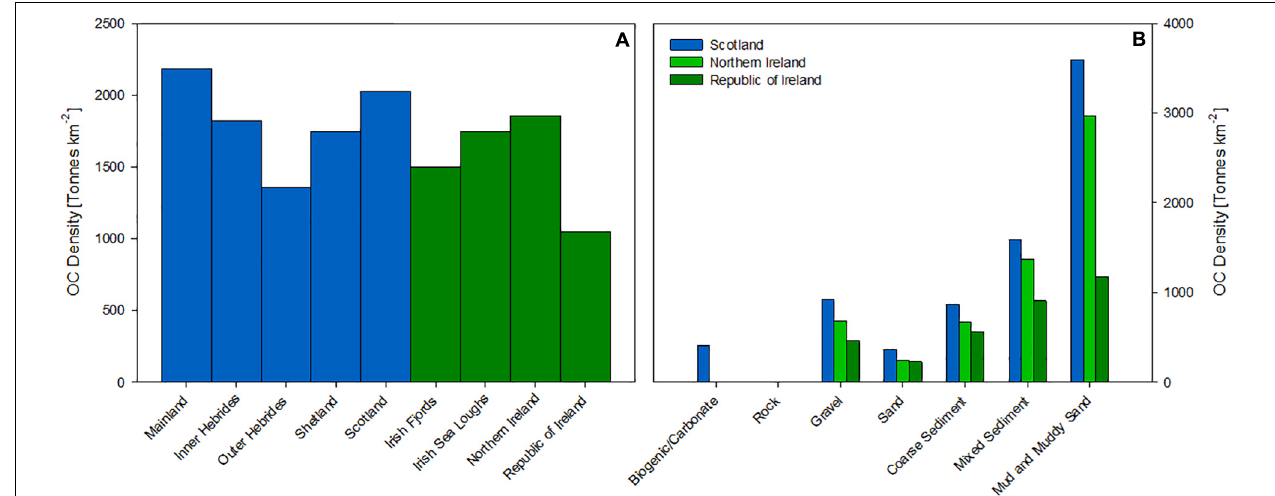
FIGURE 9 | OC density (tonnes km − 2 ) across (A) regions and nations (B) the seven Folk classes.